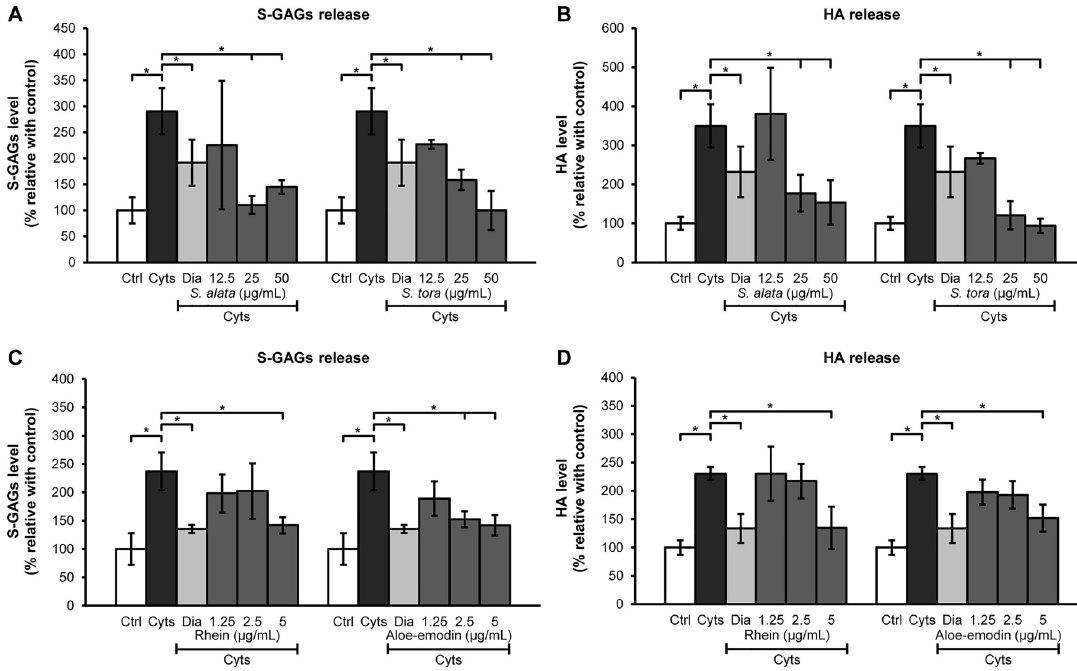
Fig 4. Levels of S-GAGs and HA in the supernatants of the short-term porcine cartilage explant culture. Results are expressed as means ± SD of the proportion between the measured level in each experimental group and the untreated control in triplicate experiments. The asterisk ( � ) indicates a significant difference at p < 0.05. Cyts: the combined cytokines (2ng/mL IL-1 β and 4 ng/mL IL- 17A); Ctrl: control (untreated group).